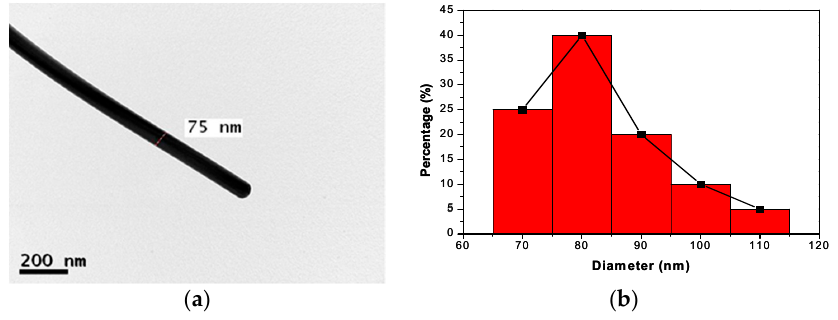
Figure 1. Synthesized silver nanowires (AgNWs): ( a ) transmission electron microscopy image; ( b ) diameter distribution of the purified AgNW.